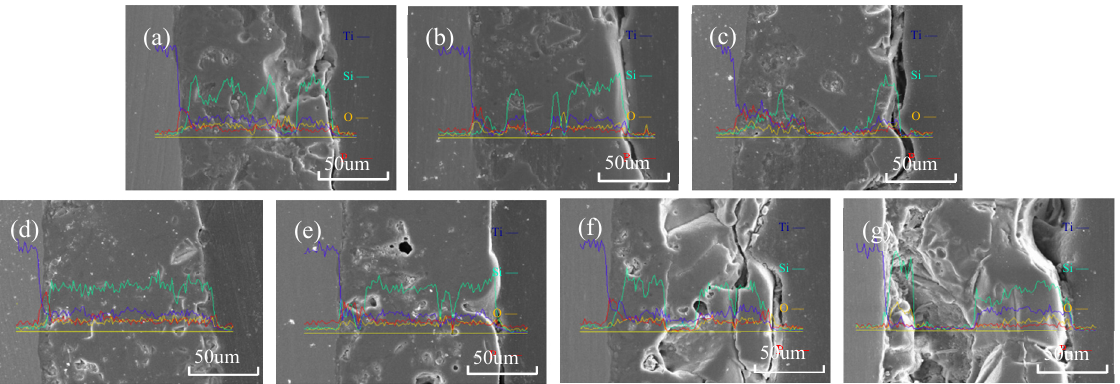
Figure 4. Line scan of MAO coatings with different ZrO2 additions: ( a ) S0; ( b ) S1; ( c ) S2; ( d ) S3; ( e ) S4; ( f ) S5; and ( g ) S6.